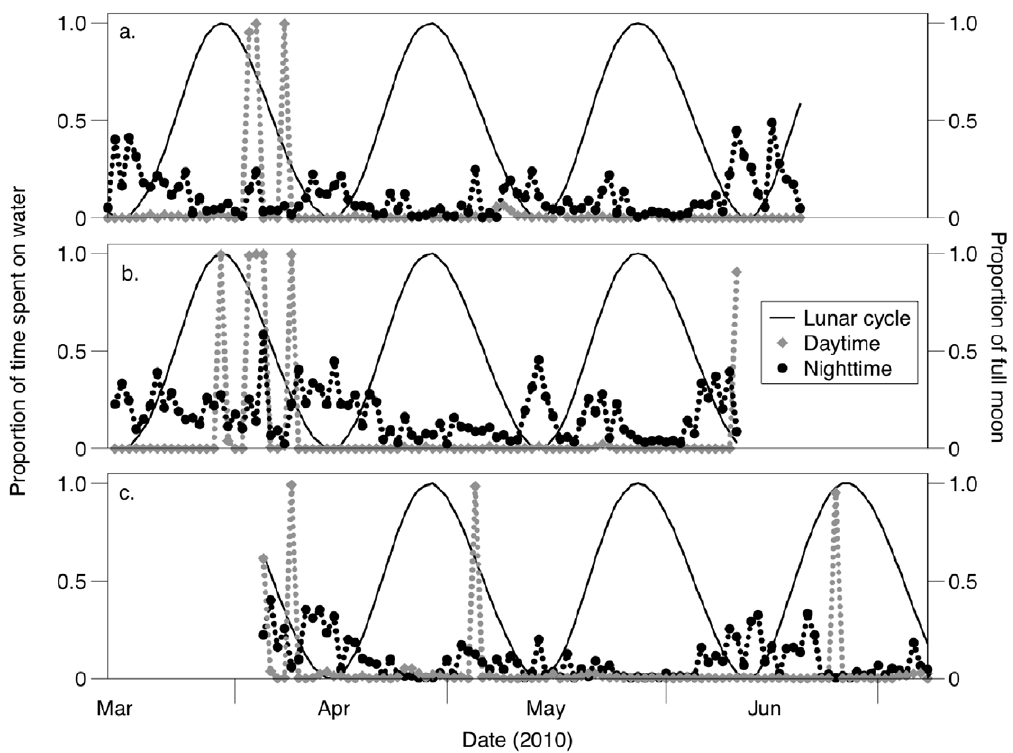
Figure 1. Percentage of time spent on water of three swallow-tailed gulls ( Creagrusfurcatus ) during the breeding season. Black circles represent nighttime values and grey circles daytime values; solid black line represents the lunar cycle.